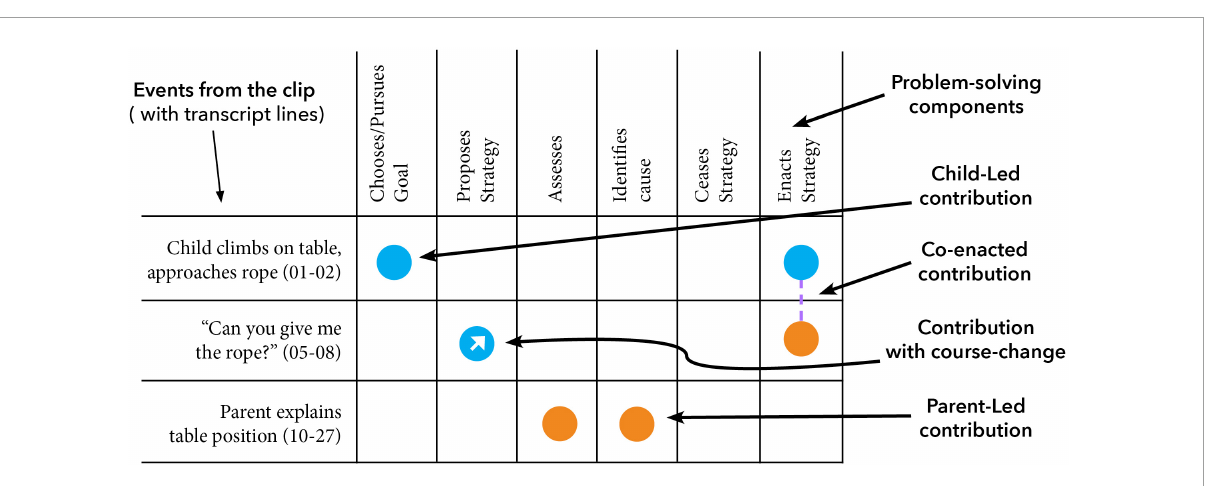
FIGURE2 A sample portion of the decomposed analysis